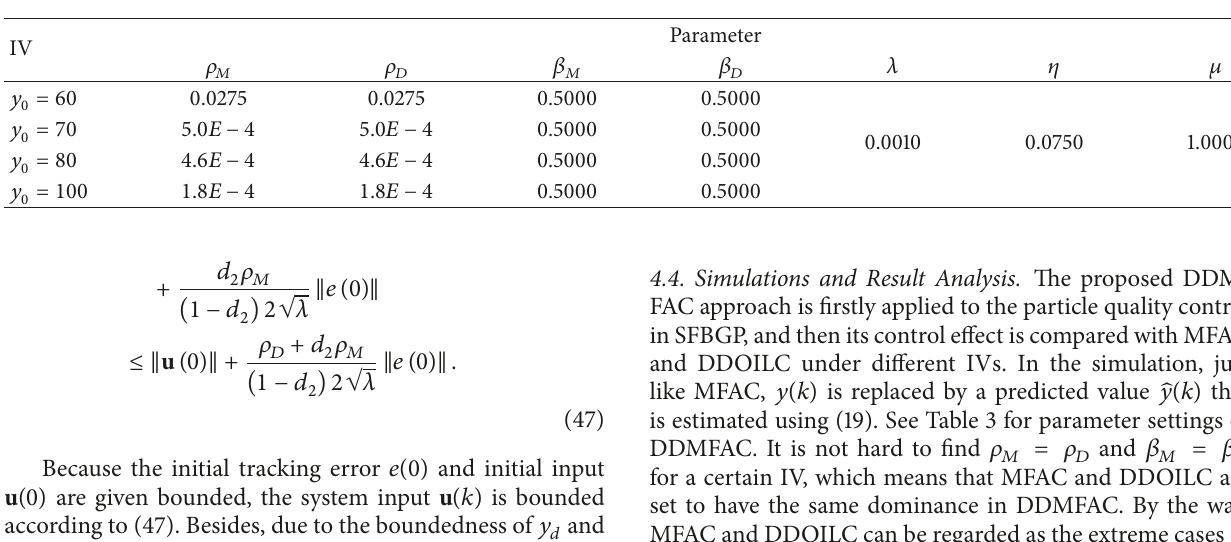
Table 3: The parameter settings of DDMFAC for different